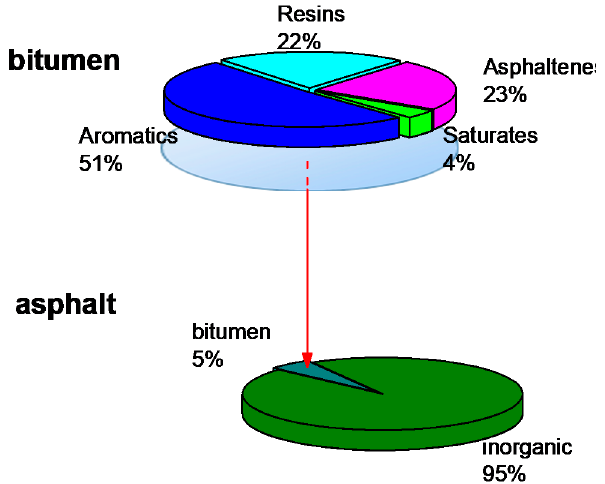
Figure 1. Typical compositions of asphalts and bitumens.